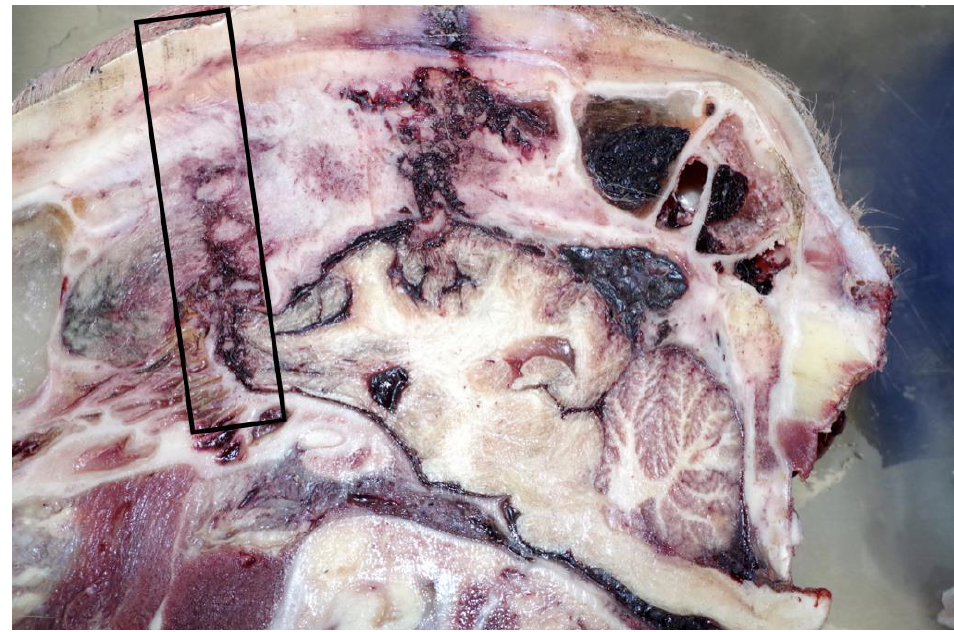
Figure 3. The trajectory of shot 1 (outlined), head right sagittal section.